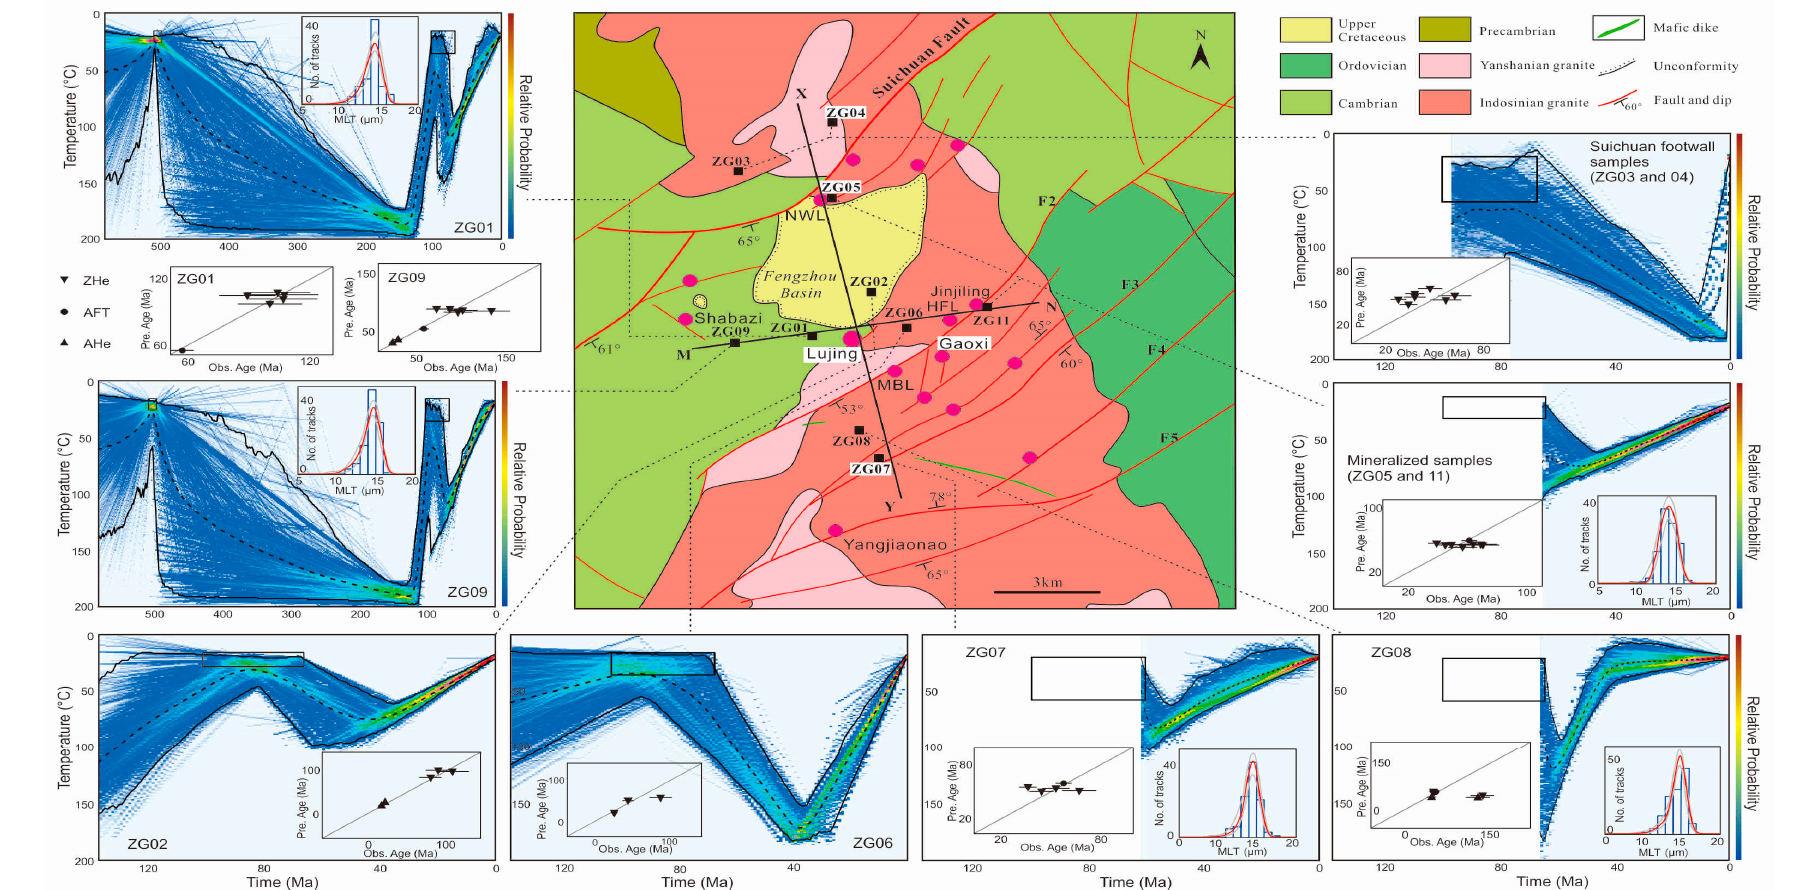
Figure 6. Inverse time–temperature (t-T) reconstructions for Lujing uranium ore field samples, generated using QTQt [49]. Note the wider temperature range of Cambrian sample t-T models. All other models were adjusted to share a common x-axis scale to facilitate visual comparison; however, QTQt did not generate pre-latest Cretaceous t-T paths for samples ZG03, 04, 05, 07, 08, and 11. See Section 3 for the thermal history modeling protocol. Black boxes represent applied t-T constraints corresponding to Cambrian and Late Cretaceous sedimentation. Black dashed lines are the best fit t-T paths and black solid lines represent the 95% confidence interval limits. Panels show corresponding observed versus predicted age and confined track distribution plots, with AFT, AHe, and ZHe ages represented by circles, triangles, and inverted triangles, respectively, and observed and predicted confined track distributions illustrated by blue bins and red curves ± the 95% confidence interval limits (light grey curves), respectively. Pre. = predicted, Obs. = observed.